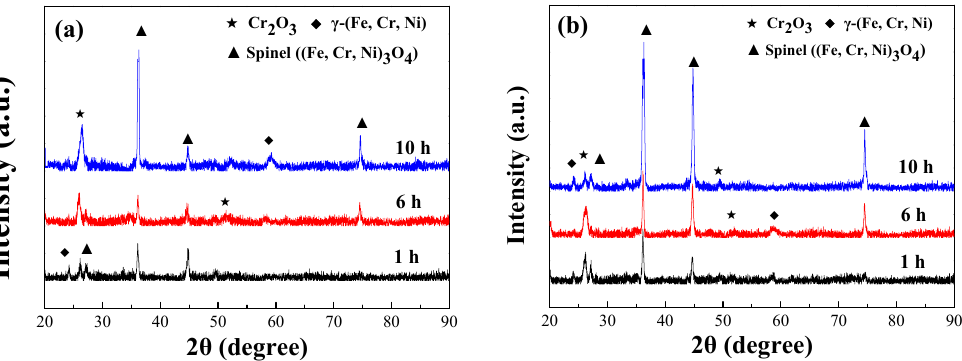
Figure 10. XRD patterns of the welded joints that underwent thermal shock at 1100 °C for various durations: ( a ) WM, and ( b ) BM.